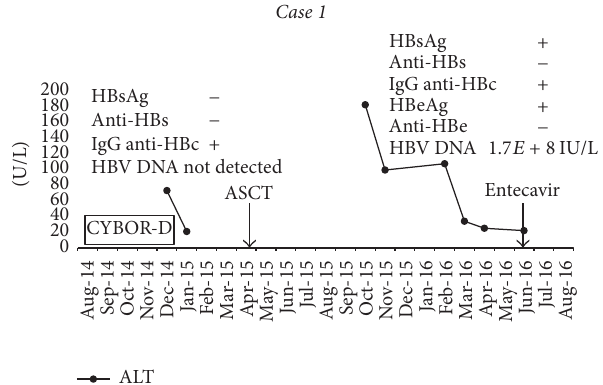
Figure 1: Liver enzymes and HBV tests in relation to chemotherapy, autologous stem cell transplant, and entecavir